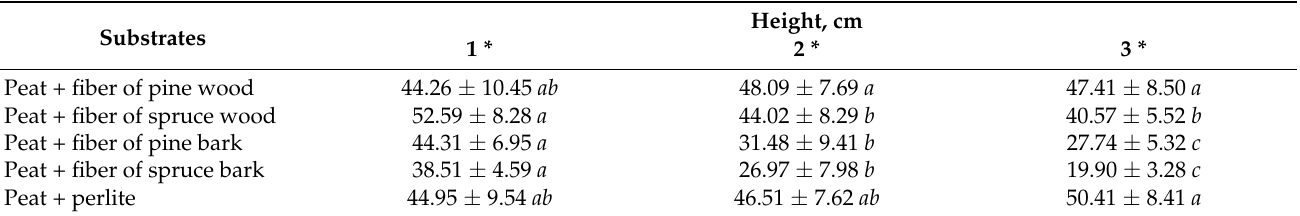
Table 3. Effect of mixes of peat with different amounts of wood and bark fibers and perlite on the height of blueberry